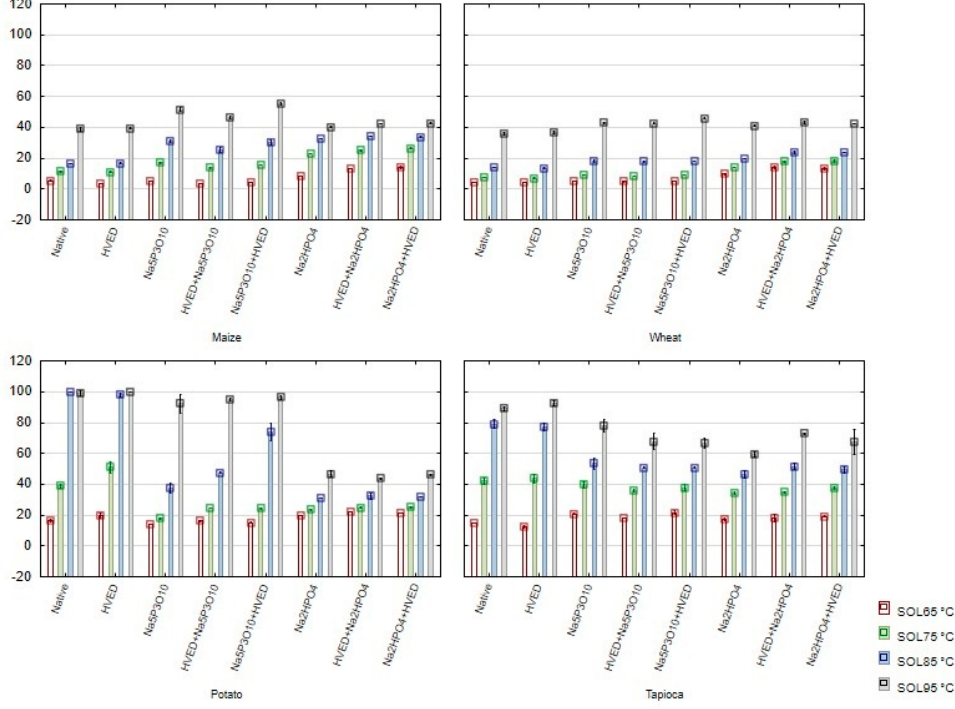
Figure 3. Solubility (SOL) (mean ± 2SD) of starches modified with high-voltage electrical discharge and phosphorylation.